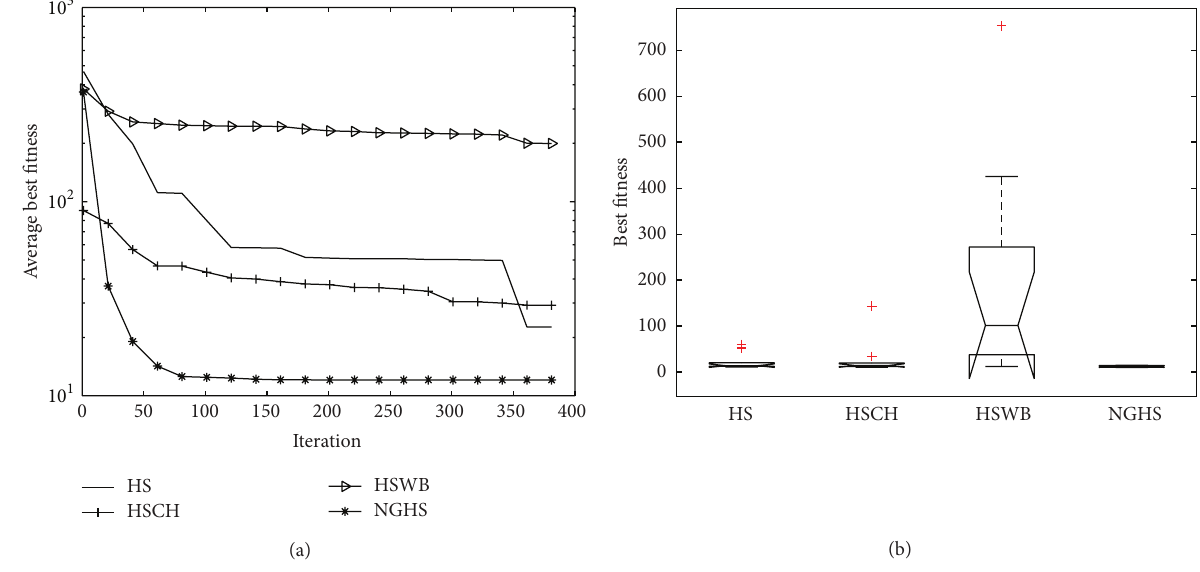
Figure 2: The convergence and its boxplot of the best fitness for LAD.